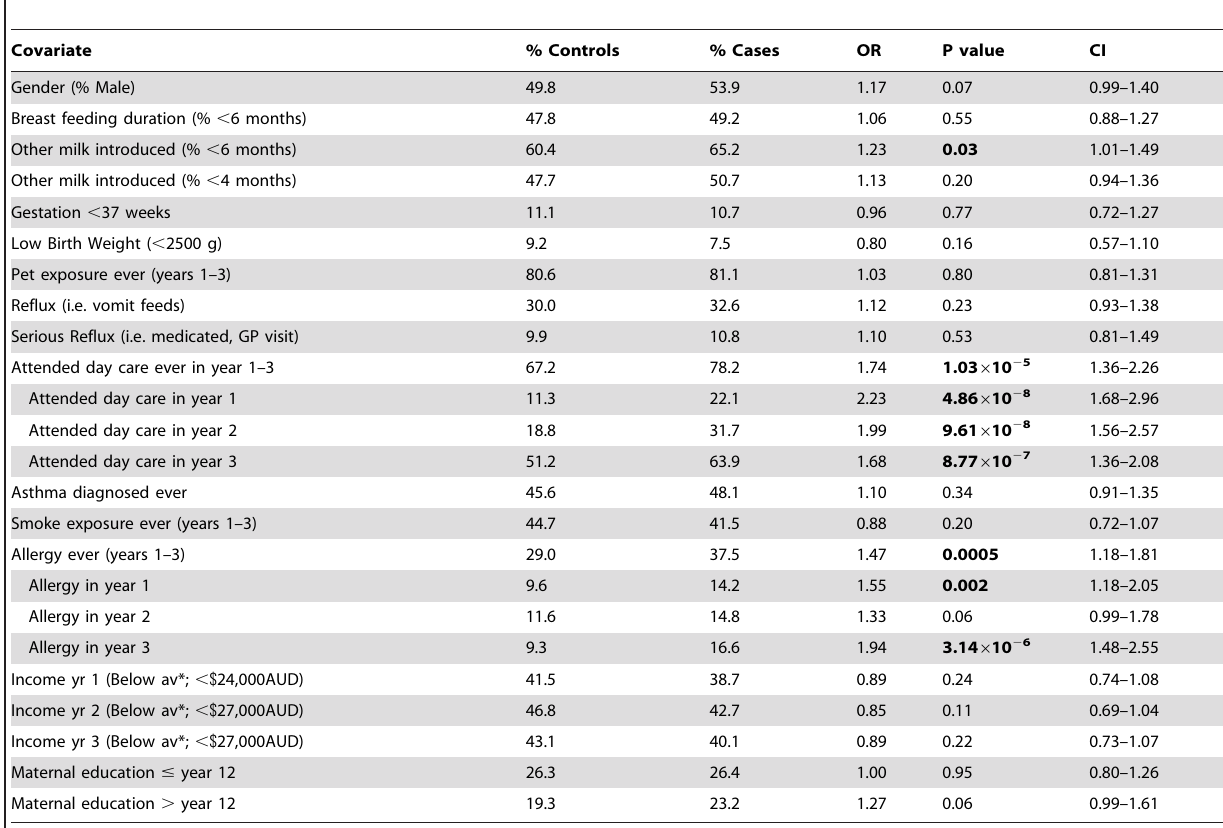
Table 3. Odds ratios (OR) and P values for demographic, environmental and clinical covariates potentially influencing OM susceptibility in childhood in the Raine Study